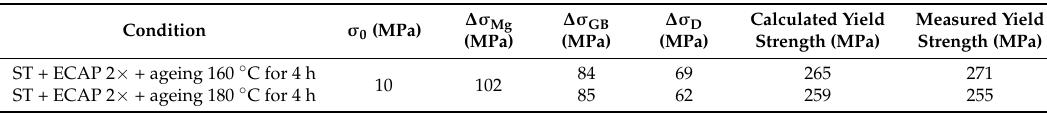
Table 5. Summary of the calculated strengthening